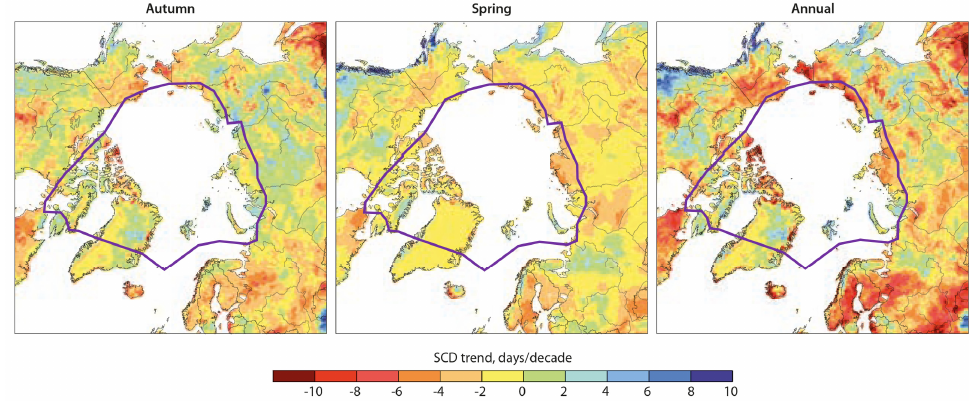
Figure 2. Annual and seasonal trends in SCD (days per decade) over the 1972/1973–2008/2009 snow seasons from the NOAA weekly snow cover maps. The territory of HA is indicated by a polygon (map reproduced with permission from AMAP [35]).